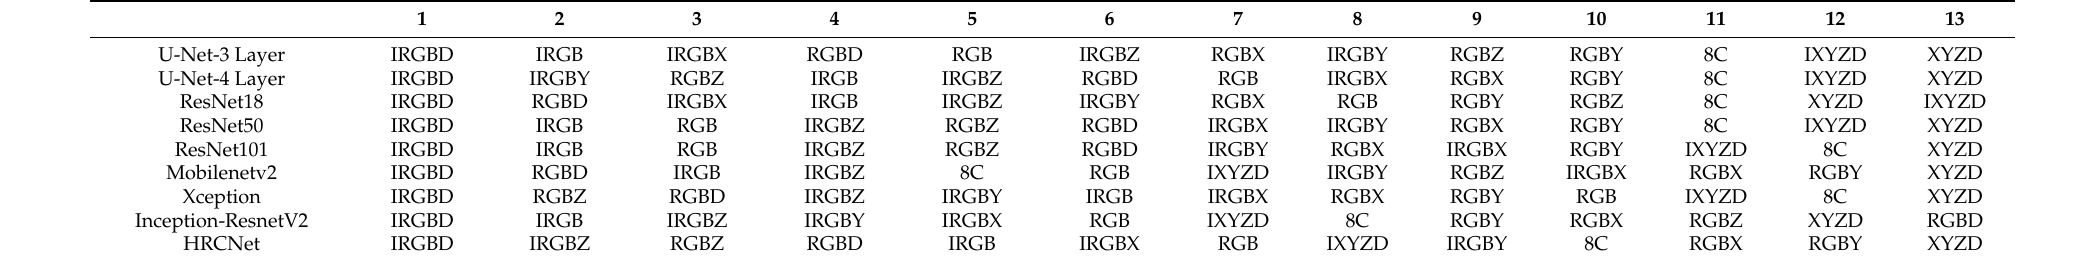
Table 6. Ranking of the mIoU performance of 13 channel combinations for seven networks.